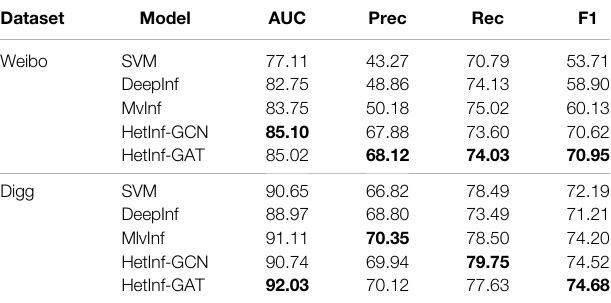
TABLE 2 | Prediction performance of different methods on the two datasets (%). Dataset Model